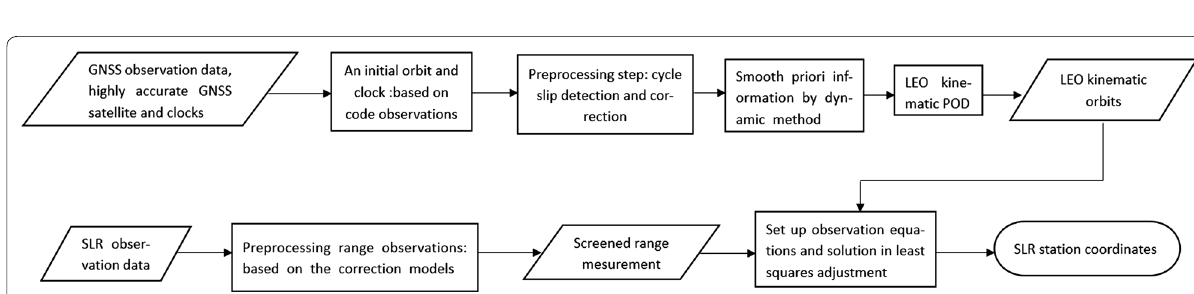
Fig. 2 Flowchart for the coordinate estimation of SLR station with a combination of the LEO satellite kinematic orbit and SLR